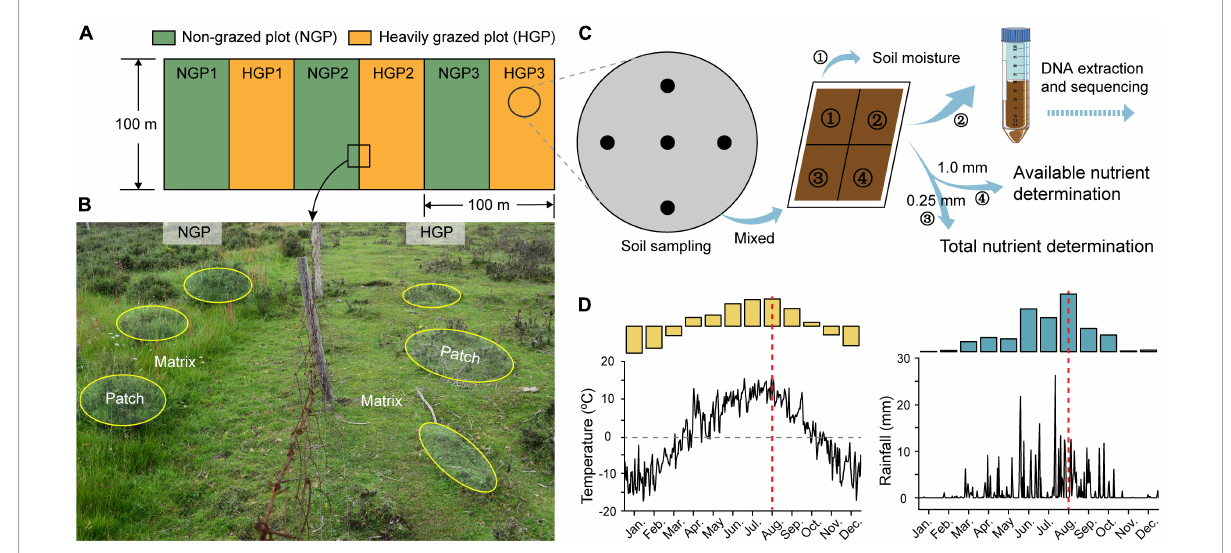
FIGURE1 Experimental set-up. (A) HGPs and NGPs were set along a shady slope direction in shrub meadows in May 2014; the area was 100 m × 50 m per plot. (B) In this set-up, the Potentilla fruticosa canopy area and the shrub intercanopy spaces are considered the patch (yellow ellipses) and matrix, respectively. Four locations were designated for analysis (M-HGP, P-HGP, M-NGP, and P-NGP). (C) Collection of soil samples. (D) Temperature and rainfall measurements of the experimental area in 2020. Microenvironment and soil data were collected in August 2020 (red dotted line in D ). See text for